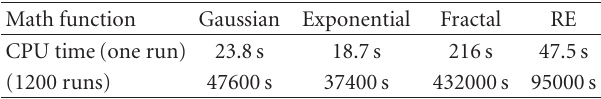
data. Table 1: CPU time comparison for di ff erent mathematical models of the random